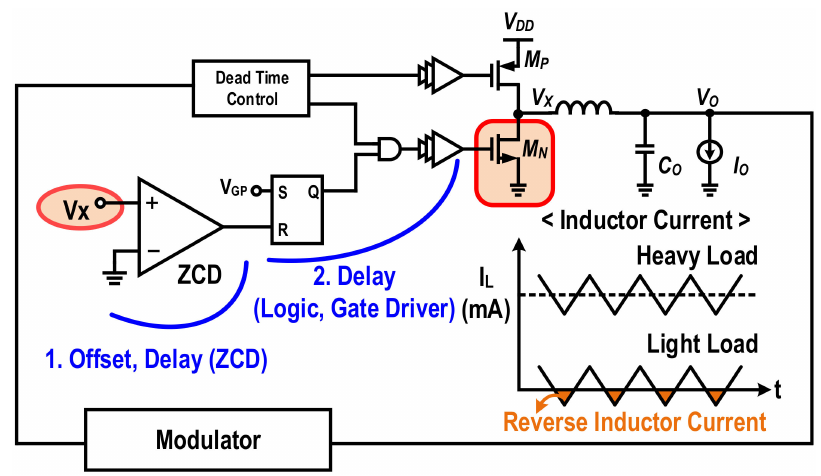
Figure 6. Zero current detection issues in conventional dc-dc buck converter.